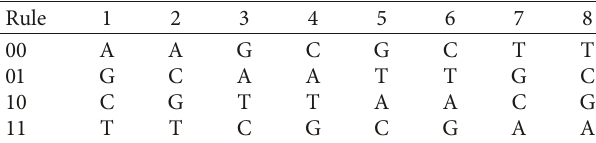
Figure 1: Simulation figure of chaotic systems. The phase diagram of (a) logistic map and (b) 2D-LSCM system. Table 1: 8 kinds of DNA coding